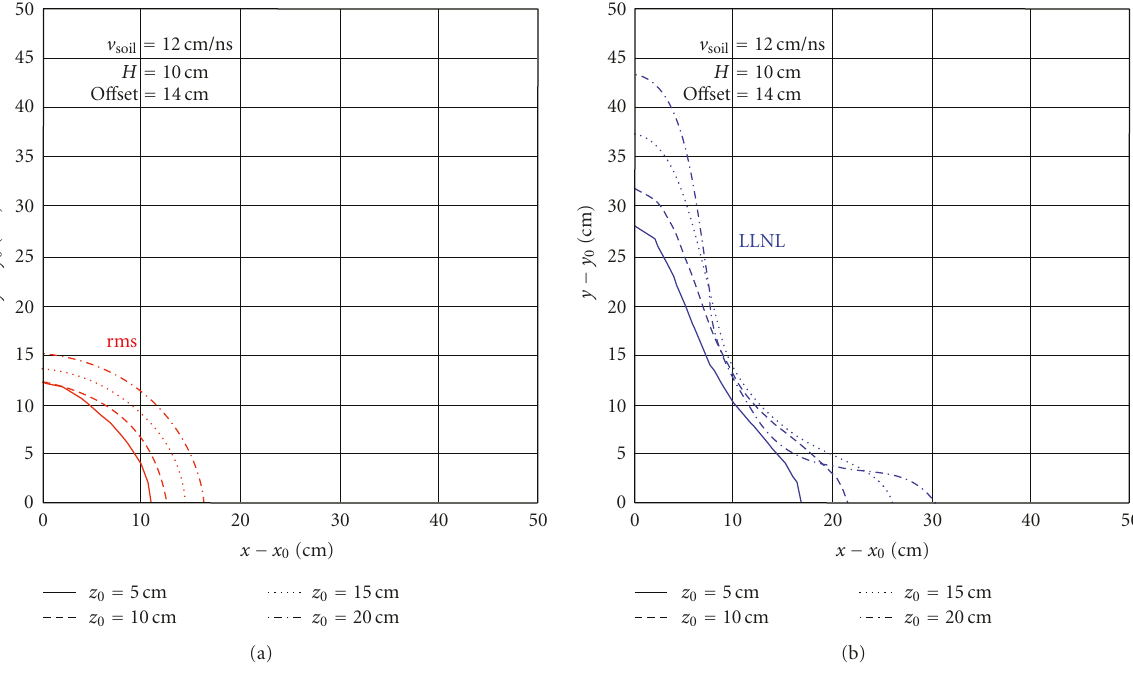
Figure 4: Migration aperture with the two-step approach for the rms (a) and the LLNL (b) approximations at four di ff erent target depths. The antenna-medium distance is 10 cm; the radar wave velocity into the medium is 12cm/ns; the TX-RX distance is 14cm with the azimuth oriented in the y